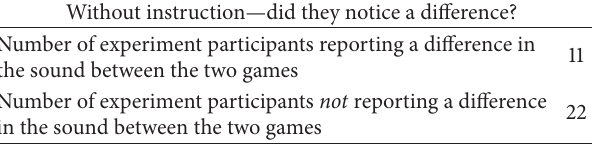
Table 3: Numbers of experiment participants that did or did not notice the correct difference in the sound without being told to focus on the sound.